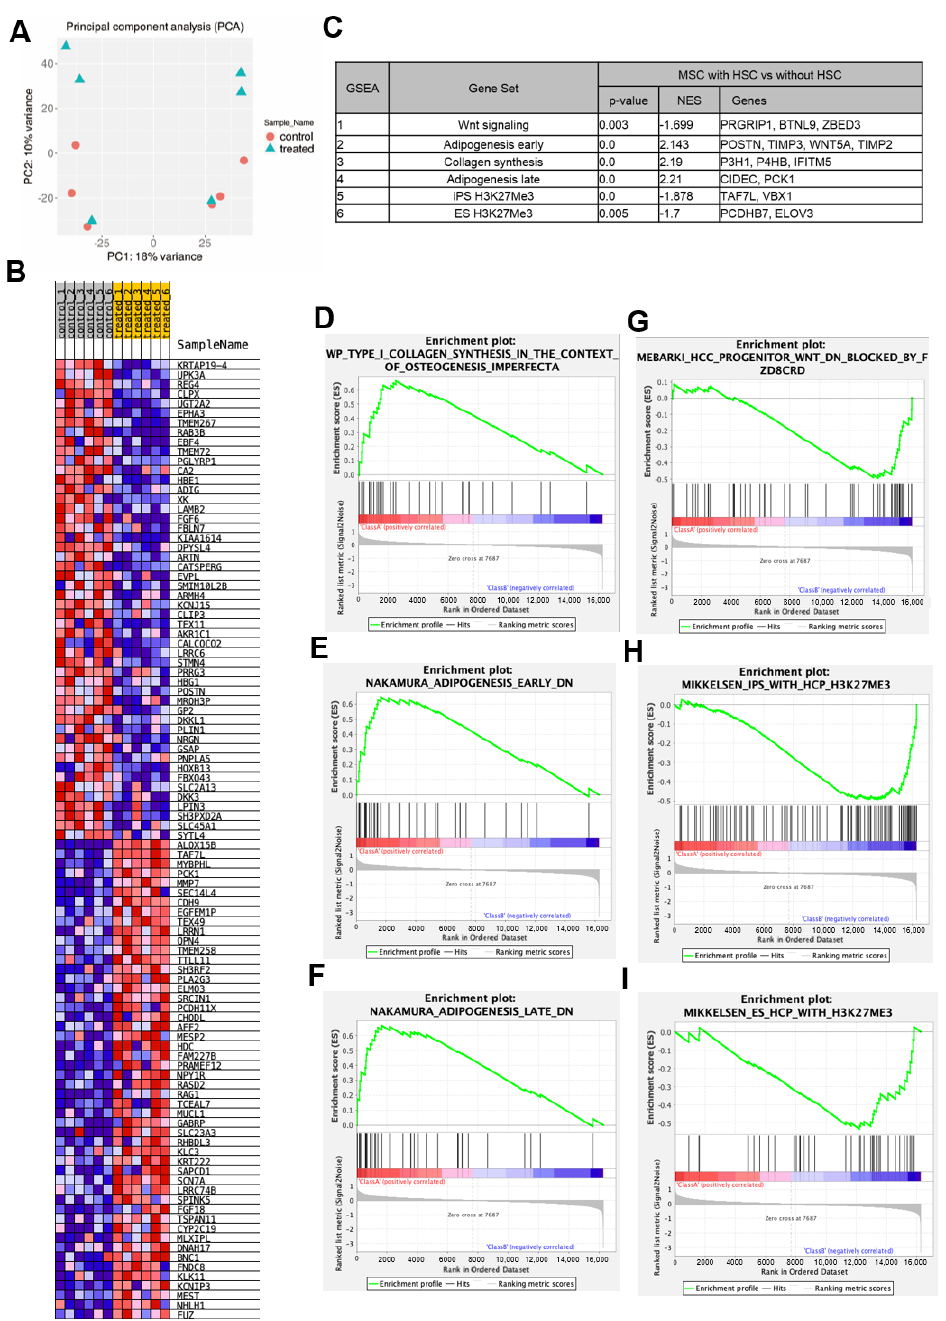
Figure 3. Gene expression analysis comparing MSCs cultured alone with those co-cultured with HSCs. ( A ) Principal component analysis (PCA) analysis of 12 samples. Orange circles: control MSC, blue triangles: MSC co-cultured with HSC. ( B ) Heatmap of differentially expressed genes between the MSC and HSC co-culture group (treated) and MSC − only group (control). ( C ) List of pathways/genes that were highly expressed in the MSC and HSC co-culture group. ( D – I ) Gene Set Enrichment Analysis (GSEA) of microarray.